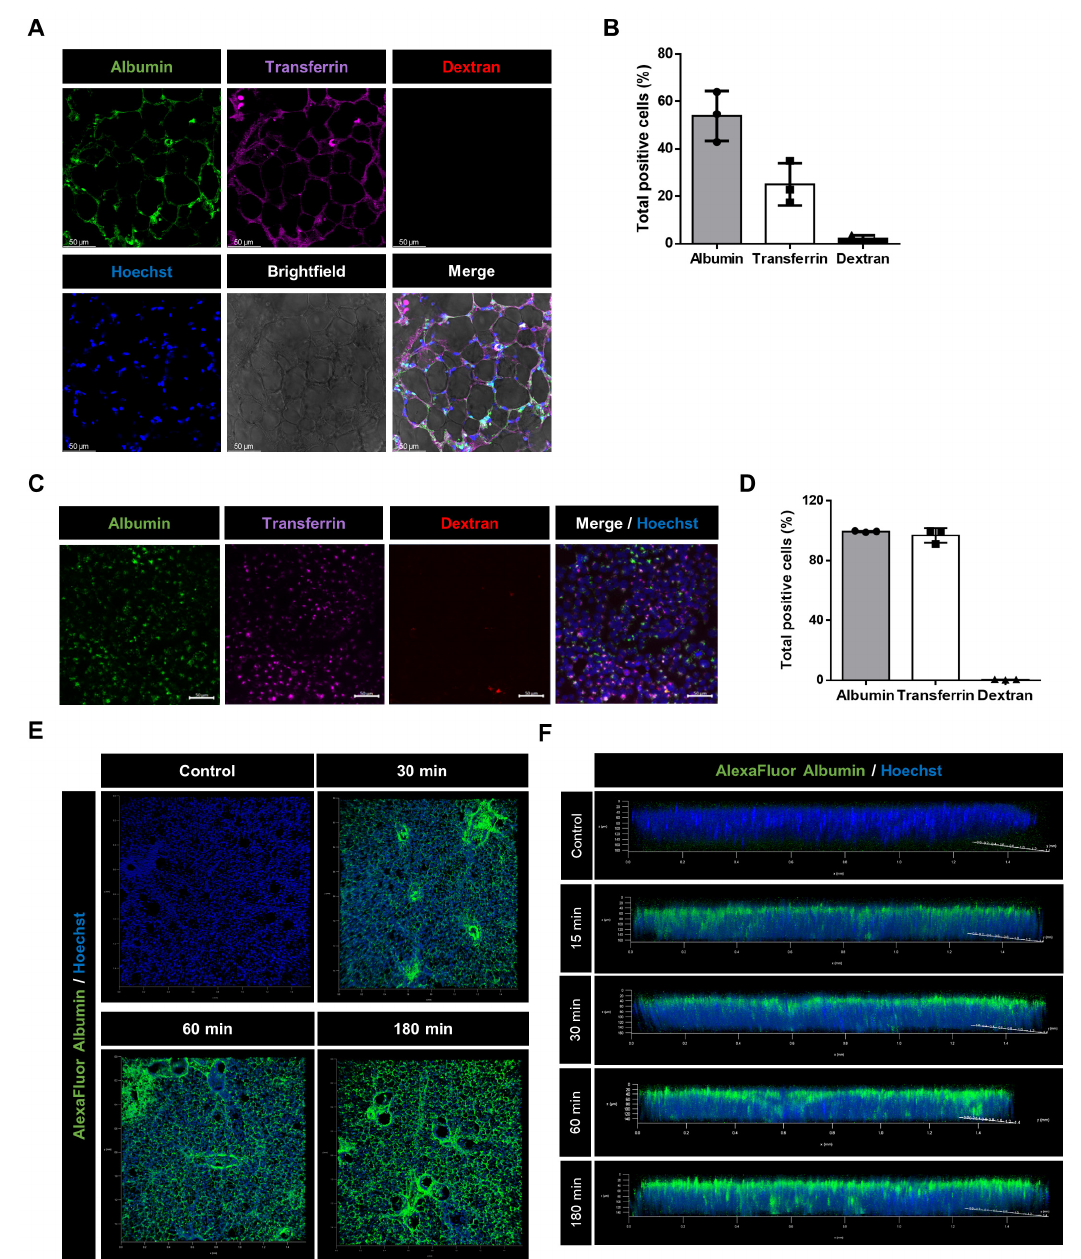
Figure 1. Albumin, transferrin, and dextran uptake in murine PCLS and mice MLE-12 epithelial cells: ( A ) PCLS were incubated for 1 h in a solution containing 250 µ g/mL of AlexaFluor488-albumin (green), AlexaFluor647-transferrin (magenta), and lysine-fixable TexasRed-dextran (70,000 Da and red). Confocal microscopy images are shown. Scale bar − 50 µ M. ( B ) Flow cytometry analysis showing frequency of cells with a positive signal for each fluorochrome isolated from PCLS (expressed as a percentage). All bar graphs show mean ± SD ( n = 3). ( C ) MLE-12 cells were incubated for 1 h in a solution containing 250 µ g/mL of AlexaFluor488-albumin (green), AlexaFluor647-transferrin (purple), and lysine-fixable TexasRed-dextran (70,000 Da and red). Immunofluorescence microscopy images are shown. Scale bar − 50 µ M. ( D ) Flow cytometry analysis showing frequency of MLE-12 cells with a positive signal for each fluorochrome (expressed as a percentage). All bar graphs show mean ± SD ( n = 3). ( E , F ) Frontal and lateral views of PCLS treated for different time intervals with AlexaFluor488-albumin (green) and stained with Hoechst (blue). Representative images are